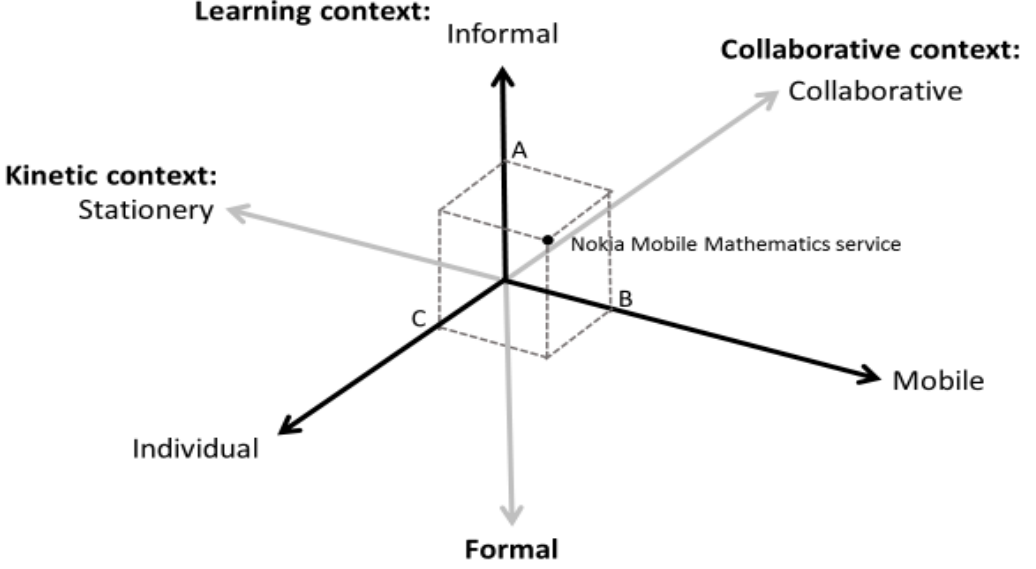
Figure 1 Variations on mobile learning configurations Table 1 Categories of use for the service Category of